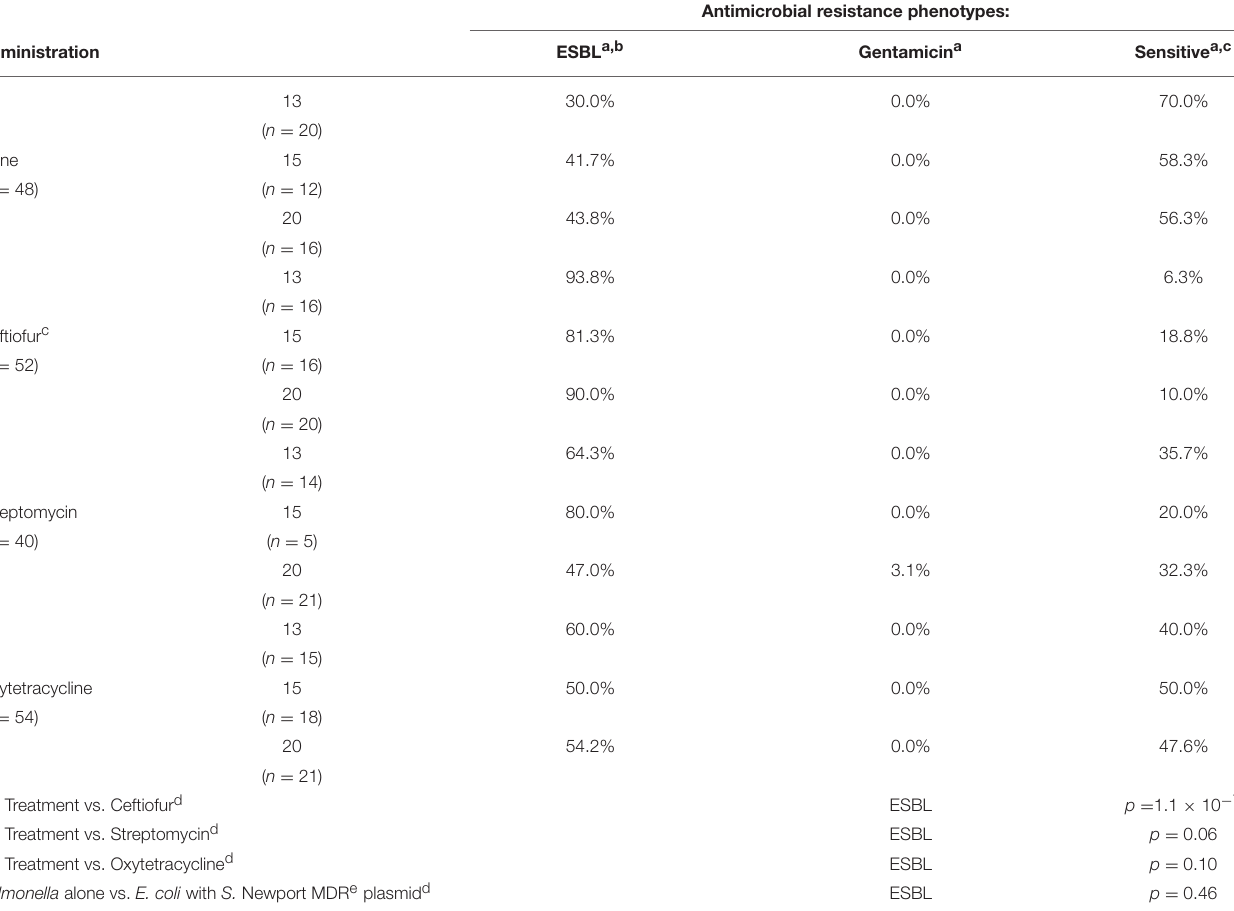
Antimicrobial resistance